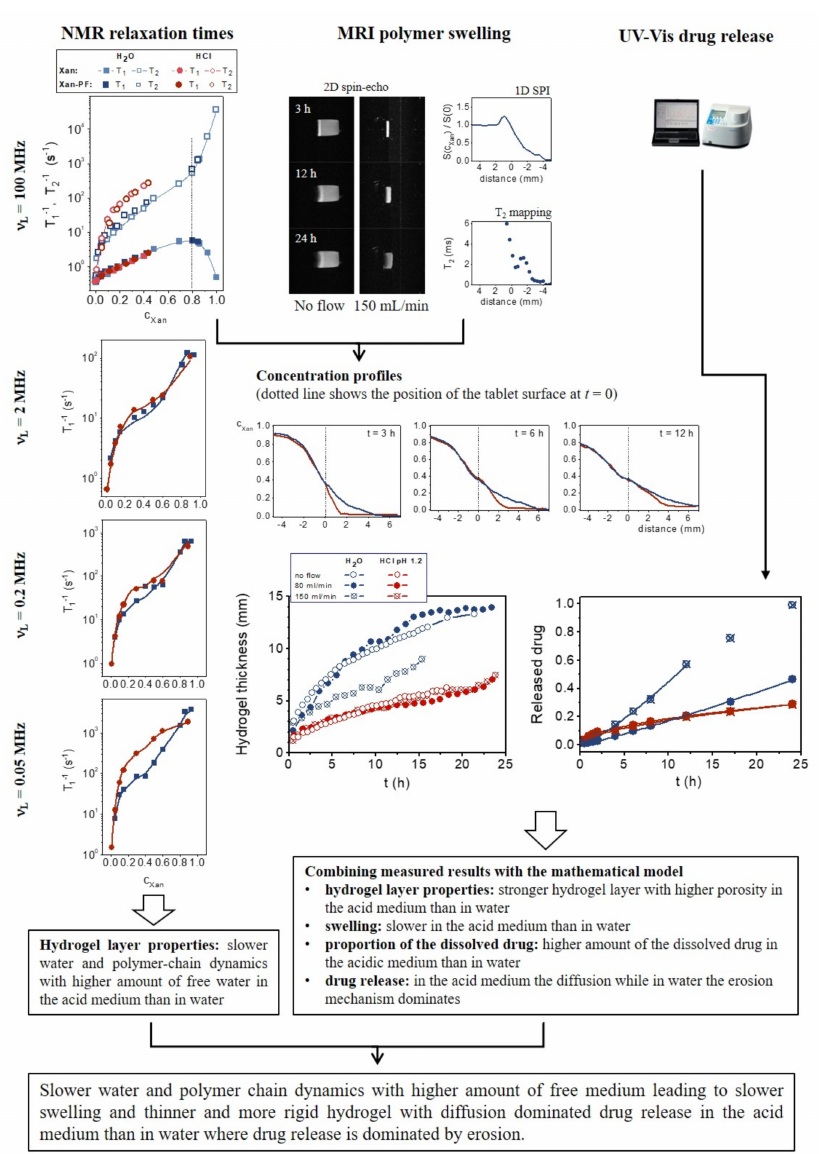
Figure 3. The use of MR methods in the study of the matrix tablets of the xanthan (Xan)